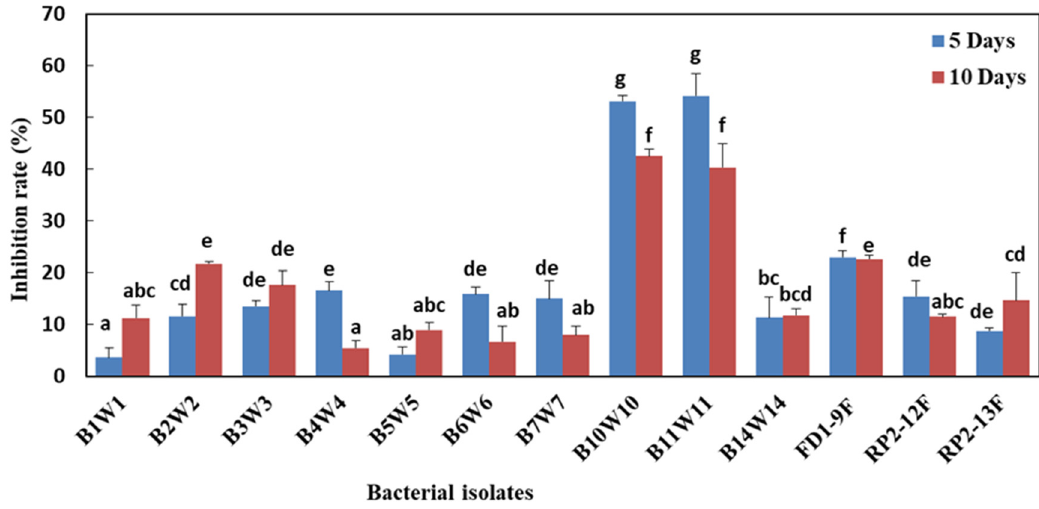
Figure 3. Inhibition rates of mycelial growth of M. fructigena obtained with bacterial cell-free filtrates. Data in the figure represent the mean of two independent trials with 4 replicates. In each incubation period, treatments having the same letter are not significantly di ff erent according to the LSD test ( p <